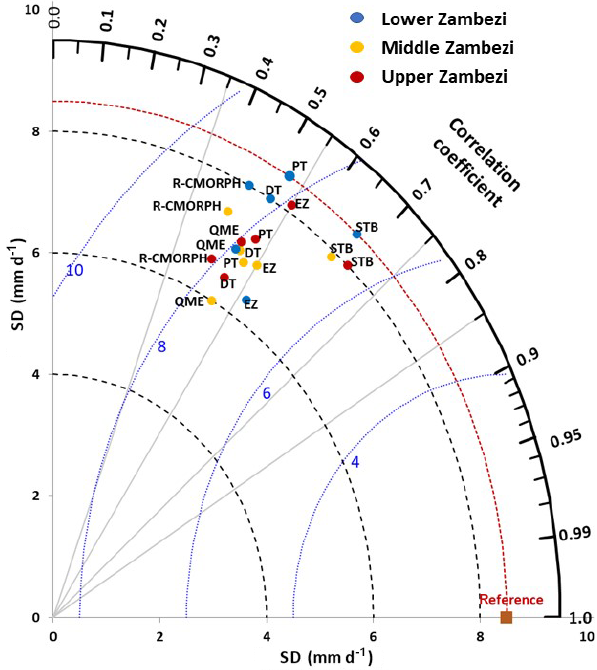
Figure 6. Taylor’s diagram on rain-gauge (reference) observations and CMORPH bias-corrected estimates (all five schemes) as av- eraged for the Lower Zambezi (LZ), Middle Zambezi (MZ), and Upper Zambezi (UZ) for the period 1999–2013. The distance of the symbol from point (1, 0) is also a relative measure of the bias- correction scheme performance. The position of each symbol ap- pearing on the plot quantifies how closely precipitation estimates by a respective bias-correction scheme match counterparts by rain gauges. The dashed blue lines indicate the root mean square differ- ence (mmd − 1